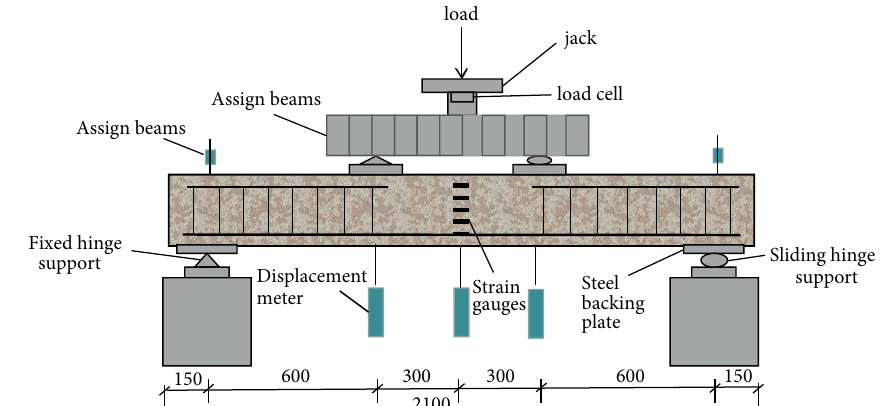
Figure 5: Lading point layout.